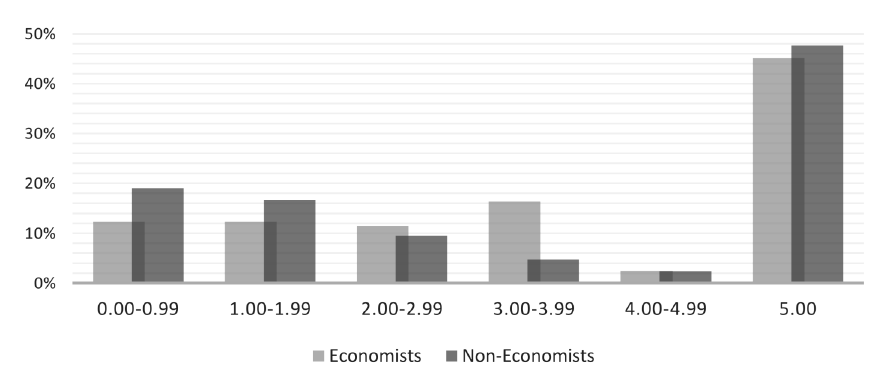
Figure 1. Distribution of donations to the common fund for economists and non- economists (in